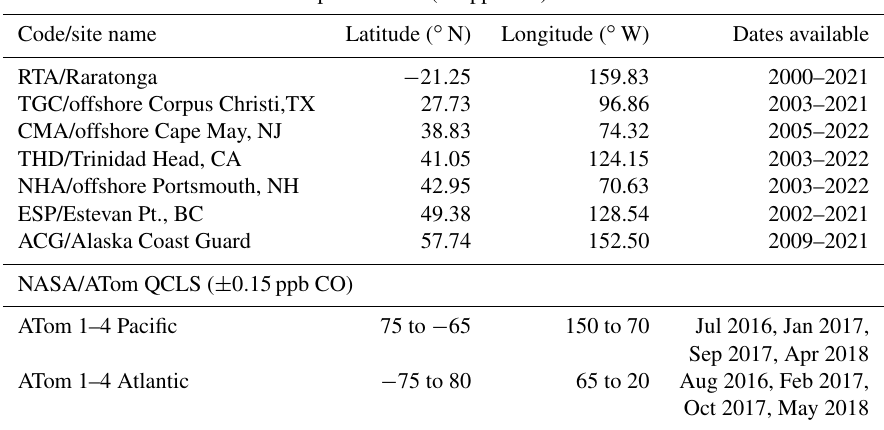
Table 1. Aircraft in situ validation observations used in this